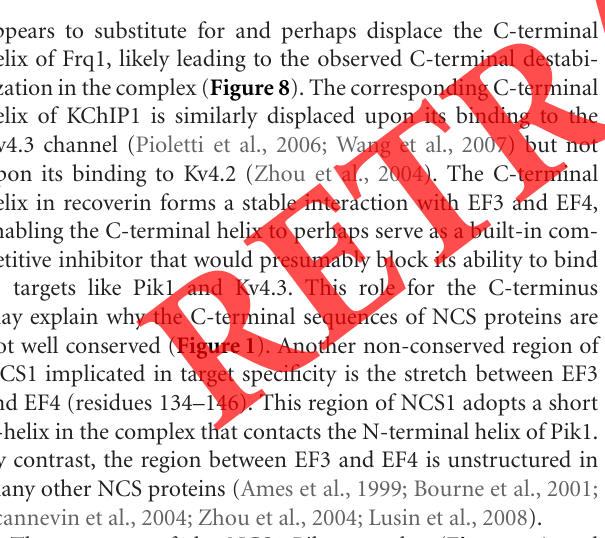
FIGURE 8 | Schematic diagram of calcium-myristoyl switch coupled to target regulation illustrated for NCS1 (A) and recoverin (B). Adapted from and originally published by Lim et al.